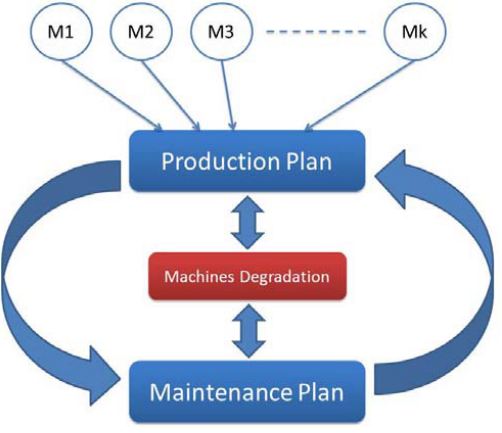
Figure 1. Problem Description.